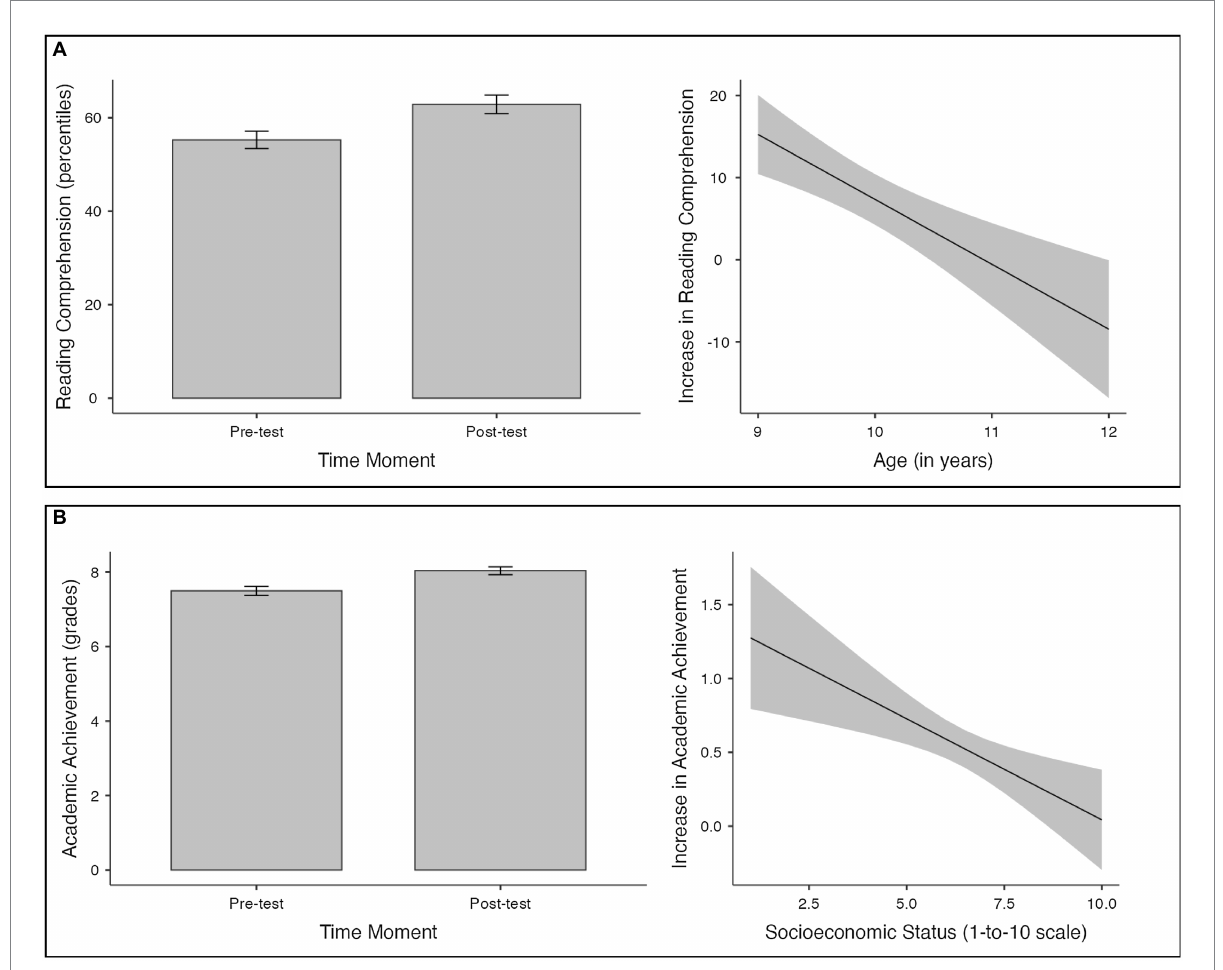
FIGURE 1 (Panel A ) Mean reading comprehension level at pre-test and post-test in the CLP test (Panel A , left) and effect of the age of the participants as a moderator variable on the differential scores between pre-test and post-test (Panel A , right). (Panel B ) Mean academic achievement at pre-test and post-test in the subject Spanish Language and Literature (Panel B , left) and effect of the socioeconomic status of the participants as a moderator variable on the differential scores between pre-test and post-test (Panel B , right). Means are presented with the 95% confidence